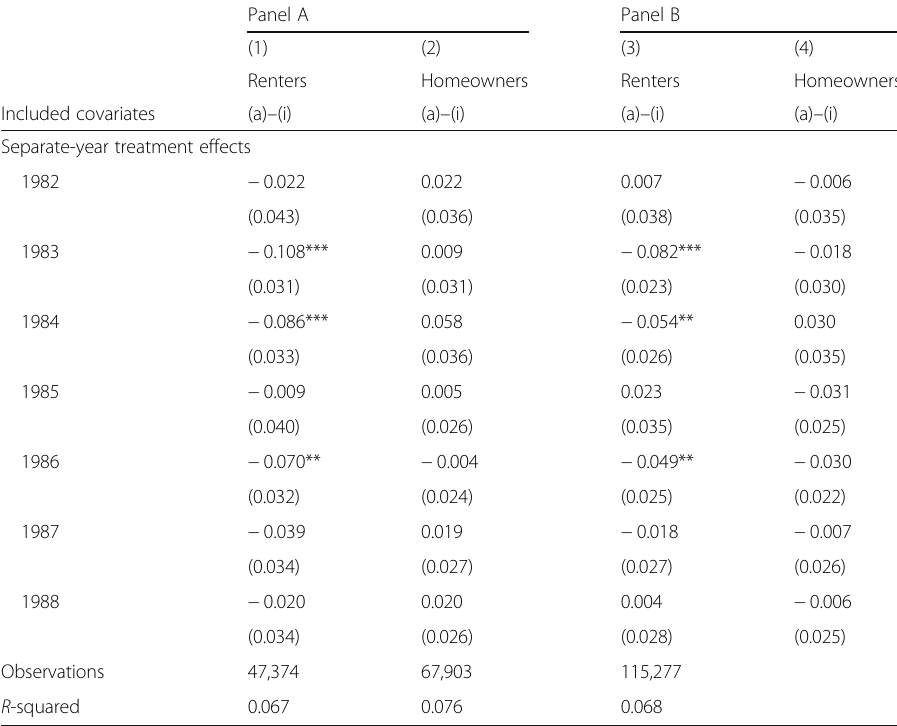
Table 8 Estimated impacts of Boatlift on fertility of women living in rented and in owned homes (using all other unaffected MSAs as the